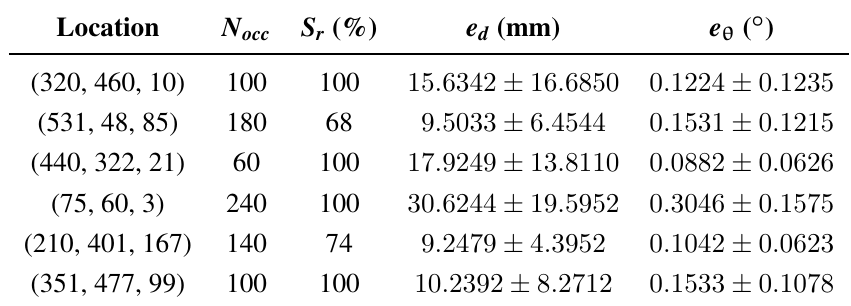
Table 4. Error and success rate for different random places. Sensor noise: standard deviation of 1% . S in % . Errors as the mean ± standard r